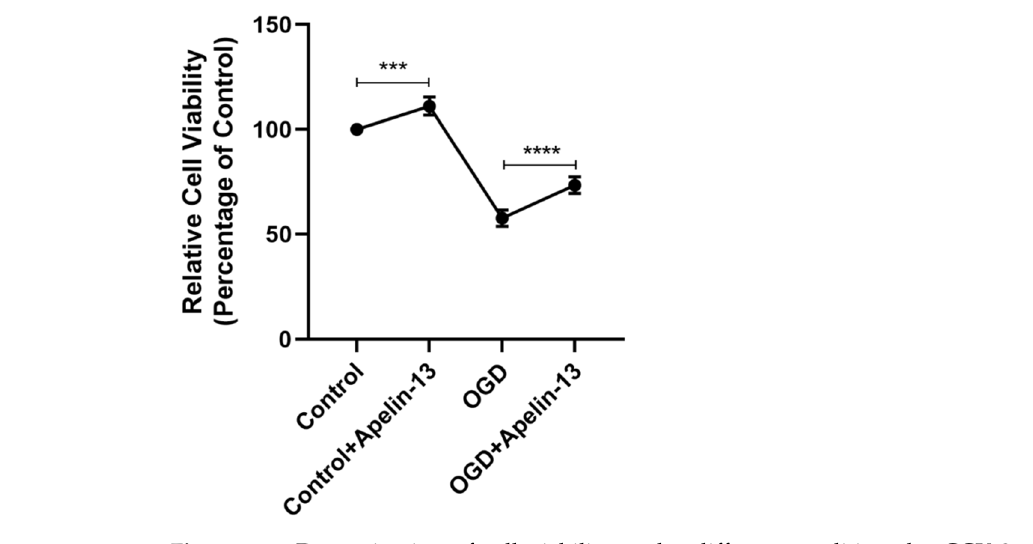
Figure 10. Determination of cell viability under different conditions by CCK-8 assay results showed that Apelin-13 can significantly improve the cell viability percentage under OGD conditions. **** p < 0.0001, *** p < 0.001.